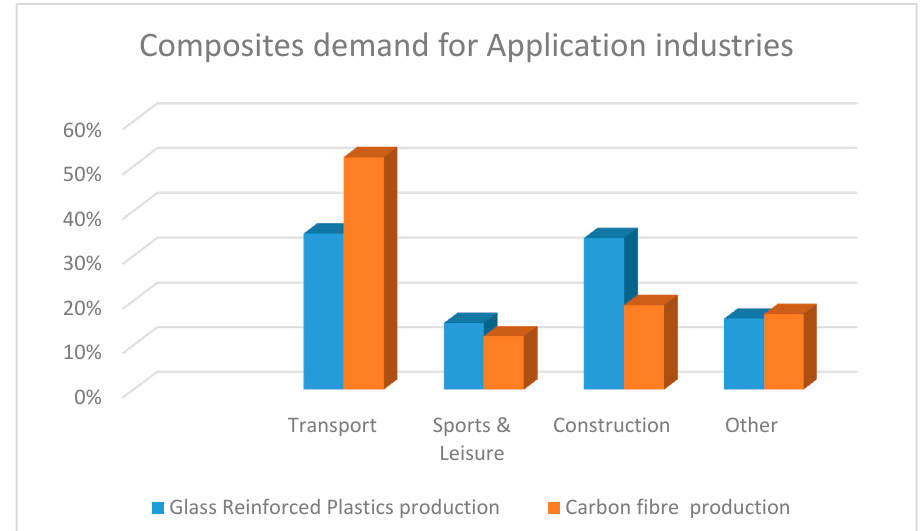
Figure 1. Percent demand of composites for industry sectors.